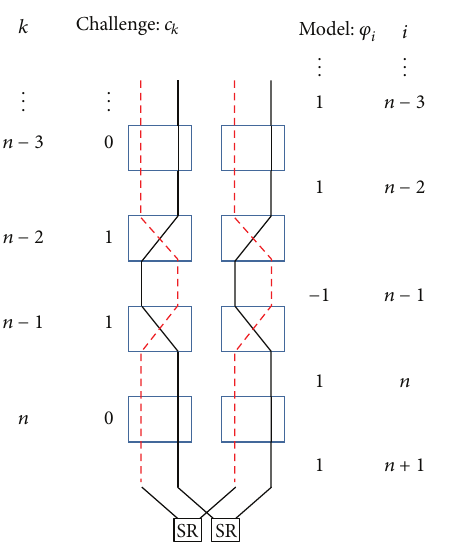
Figure 10: The challenge model for the Double Arbiter PUF.